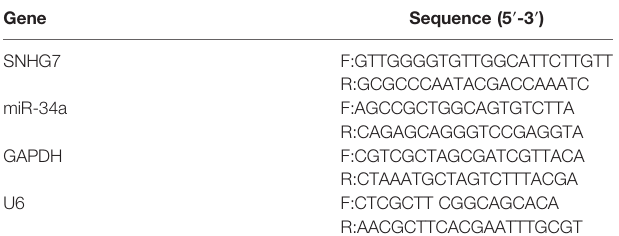
TABLE 2 | Primer Sequences For